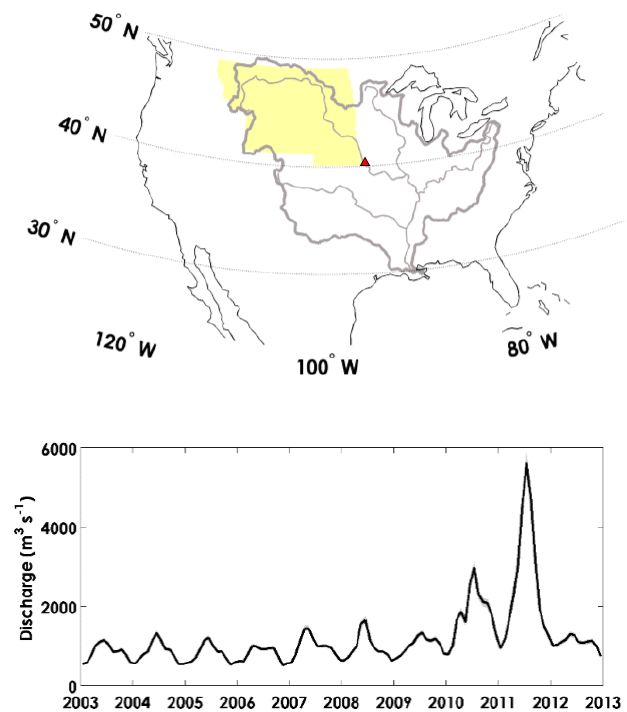
Figure 1. Study domain, stream gage near the mouth of the Missouri river, and monthly flow time